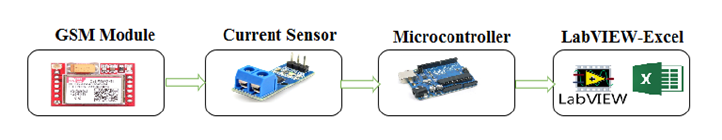
Figure 3. Current acquisition process.